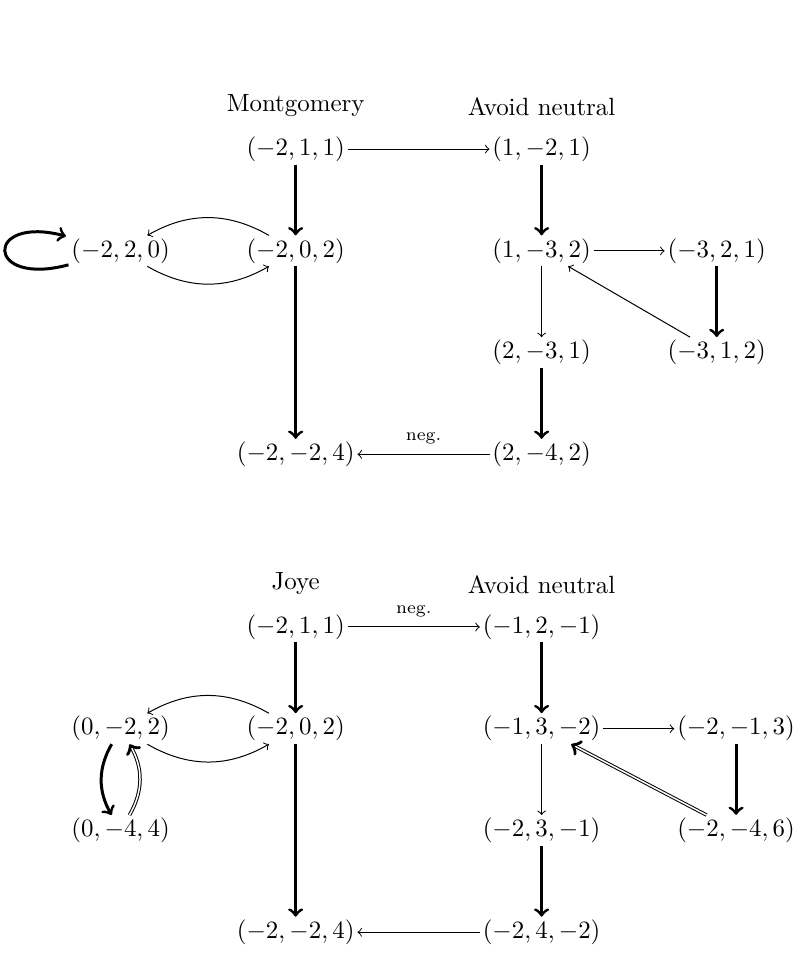
Figure 6: Avoiding the neutral